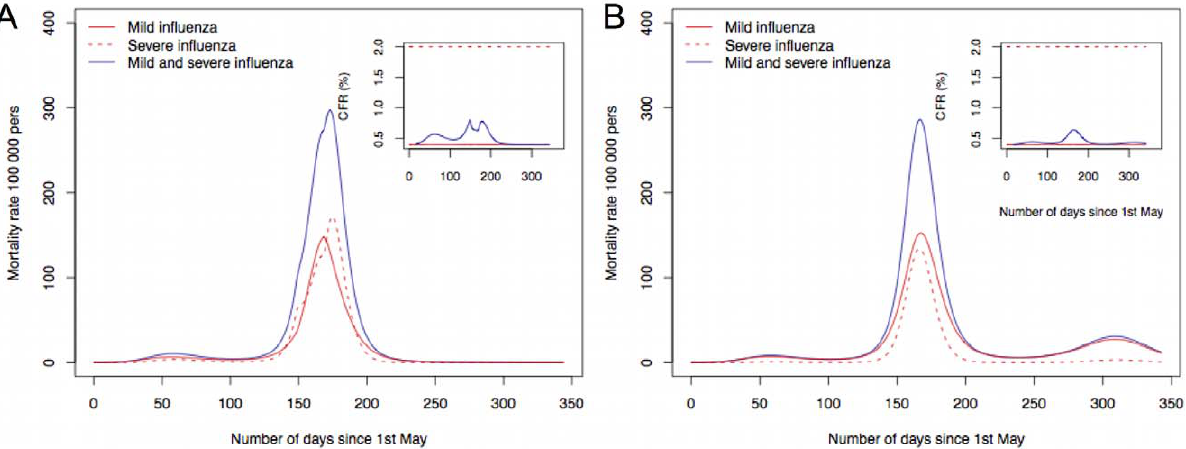
Figure 2. Dynamics of influenza pandemic with varying k and waning immunity. A a change in the level of multiple contacts as soon as the number of deaths is above 500 from k ~ 8 to k ~ 2 and B a faster rate for waning immunity in a scenario where k ~ 2 .